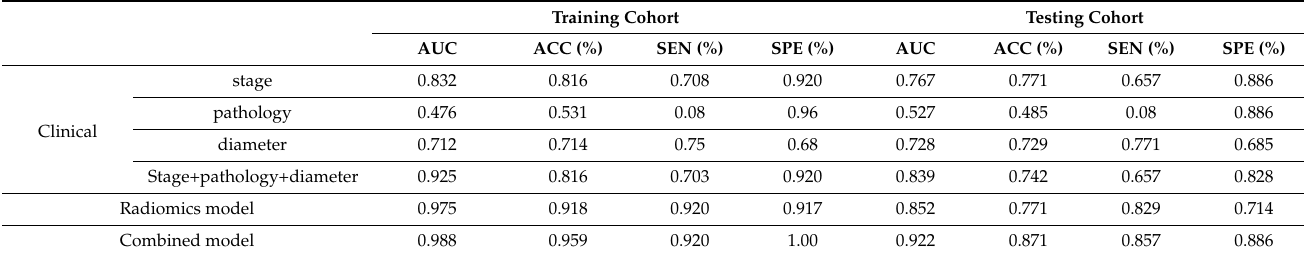
Table 2. Performance of models.